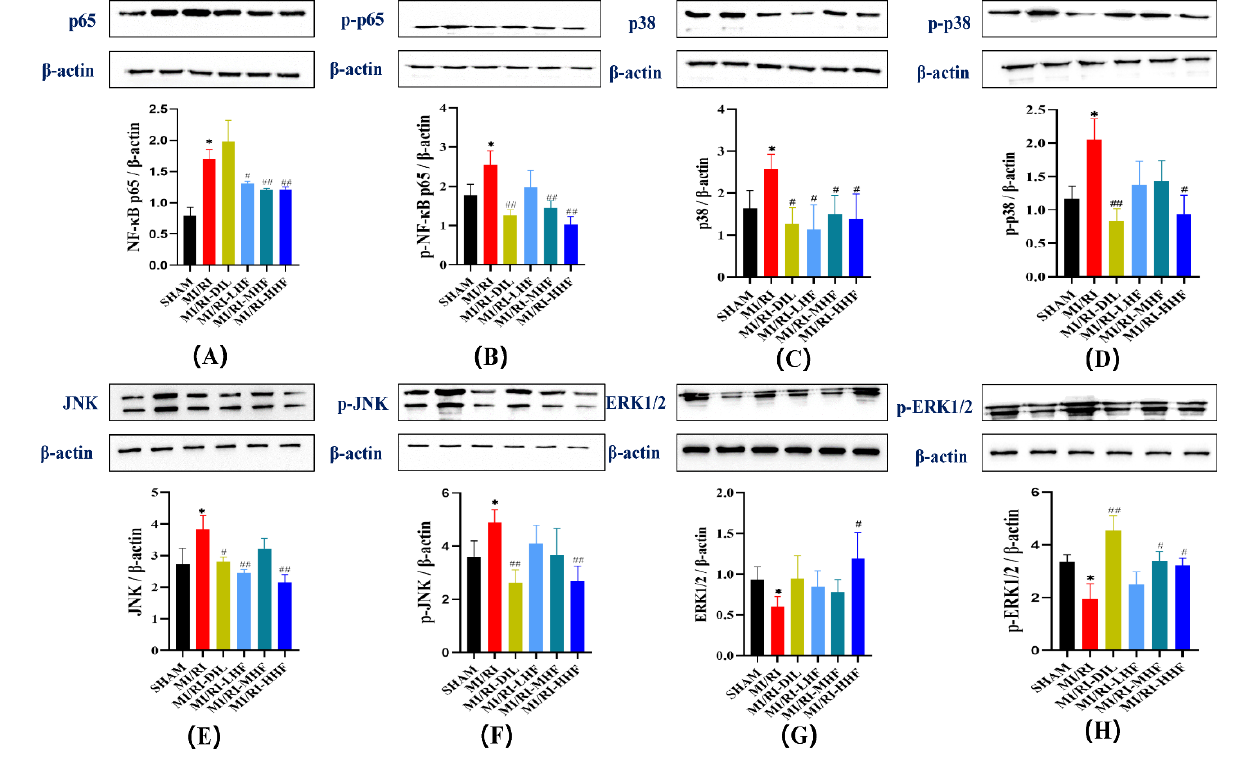
Figure 9. Effect of HF on MAPK/NF- κB protein expression. ( A ) NF- κB p65 protein relative expression. ( B ) p-NF- κB p65 protein relative expression. ( C ) p38 protein relative expression. ( D ) p-p38 protein relative expression. ( E ) JNK protein relative expression. ( F ) p-JNK protein relative expression. ( G ) ERK1/2 protein relative expression. ( H ) p-ERK1/2 protein relative expression. * p < 0.05 vs. SHAM group. # p < 0.05, ## p < 0.01 vs. MI/RI group, ( n =